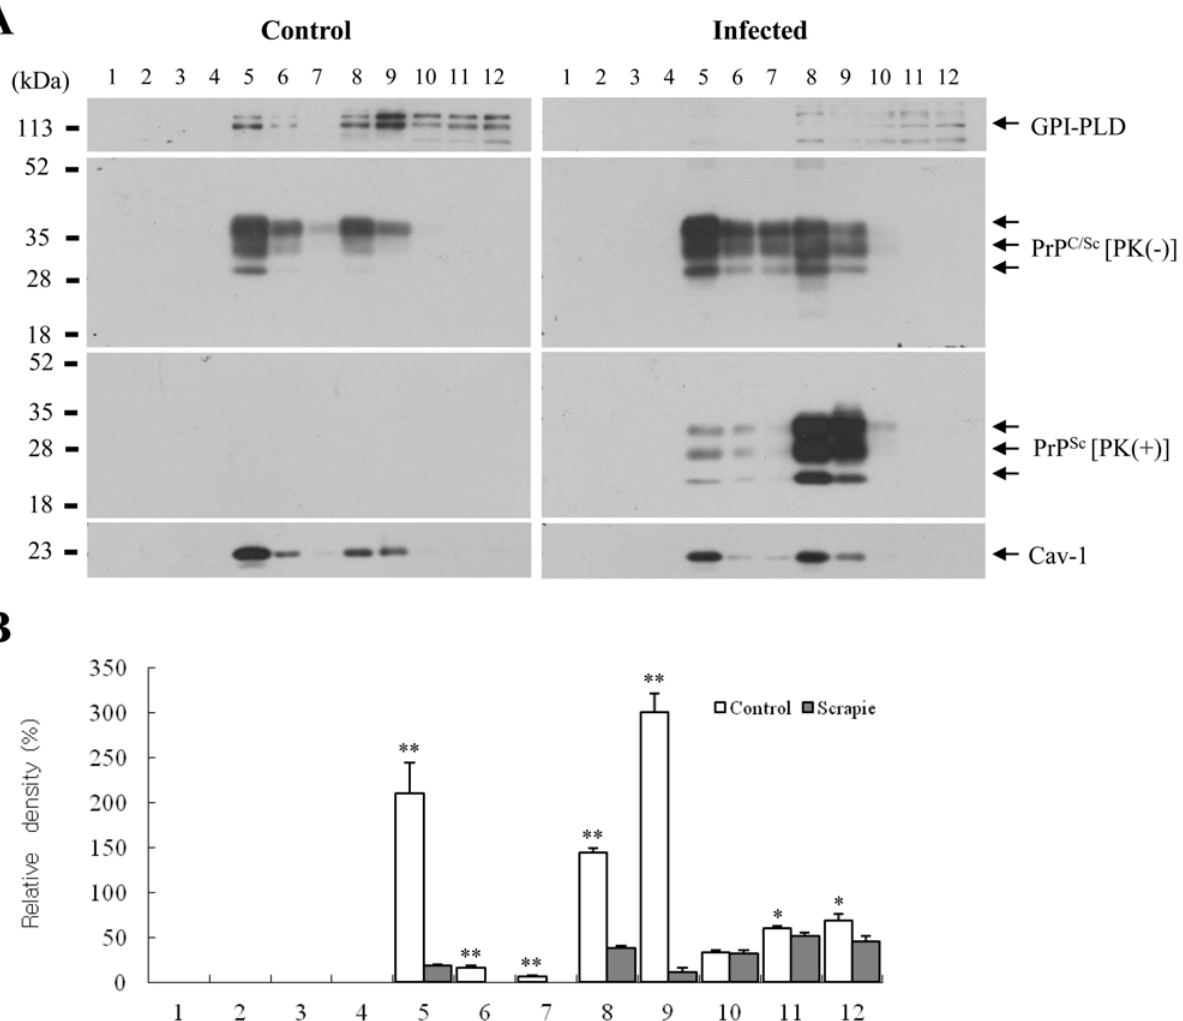
Fig 2. A decrease in GPI-PLD expression was observed in the caveolin-enriched membrane (CEM) fraction. Gradient fractions from control and from scrapie-infected brain lysates were assayed for GPI-PLD and PrP Sc as described in the Materials and Methods section. Equal sucrose gradient fractions (1 ml each following centrifugation) were analyzed by Western blotting with the anti-GPI-PLD and anti-PrP 10E4 antibodies. Each experiment was repeated at least three times, and similar results were obtained in each experiment. An anti-caveolin-1 antibody was used as the positive control for the CEM fractions. Note lanes 5, 8 and 9, in which PrP Sc and caveolin-1 are abundant. * Significance p < 0.05 compared with control levels; ** Significance P < 0.01 compared with control